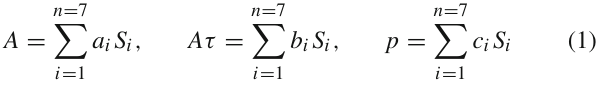
The expected time of the pulse peak is calibrated such that for particles originating from collisions at the interaction point the pulse should peak at the central (fourth) sample, synchronous with the LHC 40MHz clock. The reconstructed value of τ represents the small time phase in ns between the expected pulse peak and the time of the actual reconstructed signal peak, arising from fluctuations in particle travel time and uncertainties in the electronics